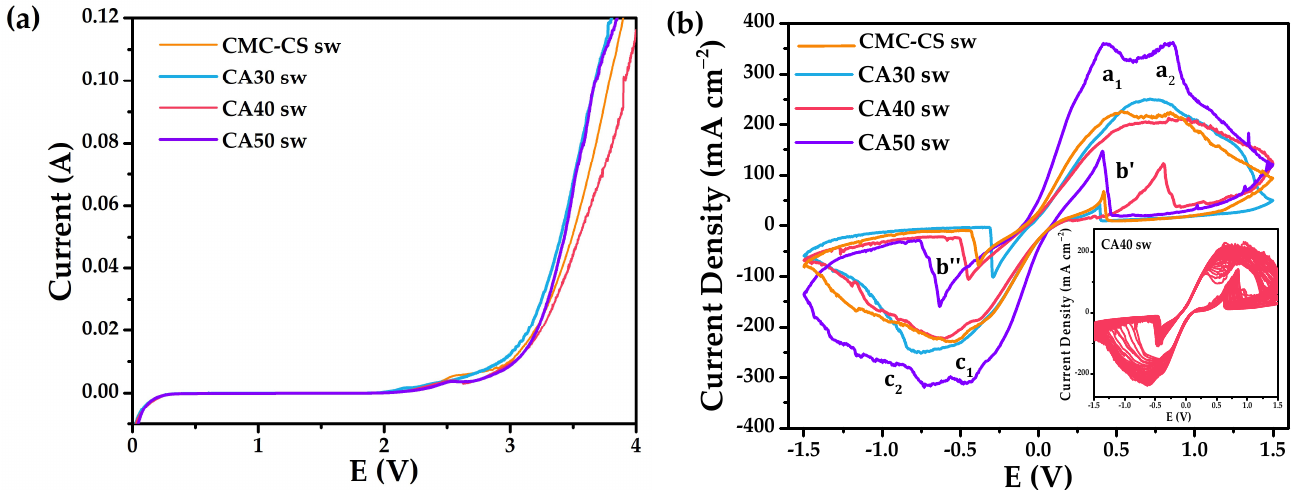
Figure 9. ( a ) Linear sweep voltammetry studies for the CMC–CS sw hydrogels at different CA proportions; ( b ) cyclic voltammograms of the swollen hydrogels at ambient temperature. Inset: 40 consecutive cycles of the CA40 sw membrane.